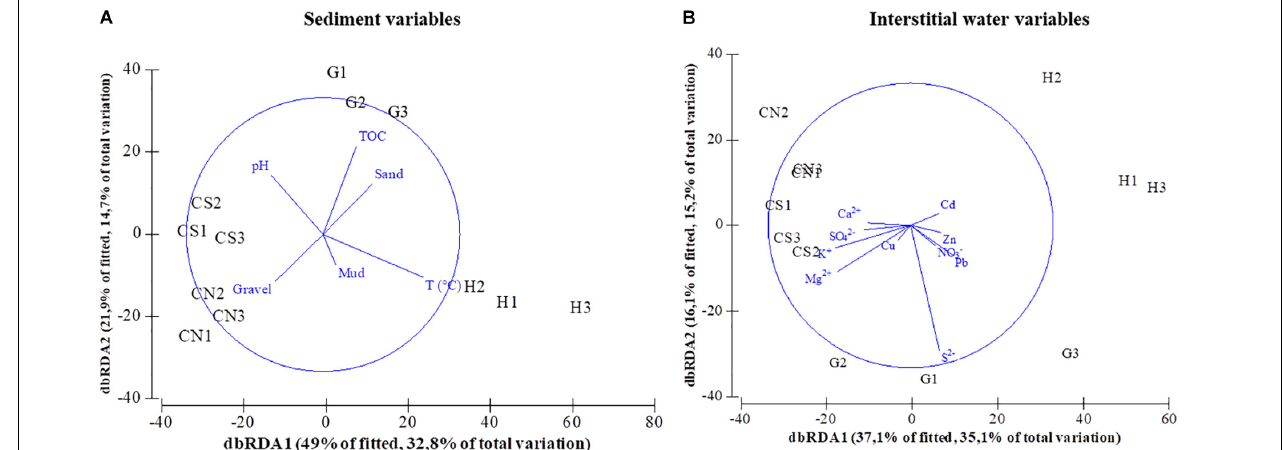
FIGURE 7 | dbRDA plot of benthic community structure fitted to sediment (A) and water variables (B) , showing each site replicated (H; G; CN; CS).